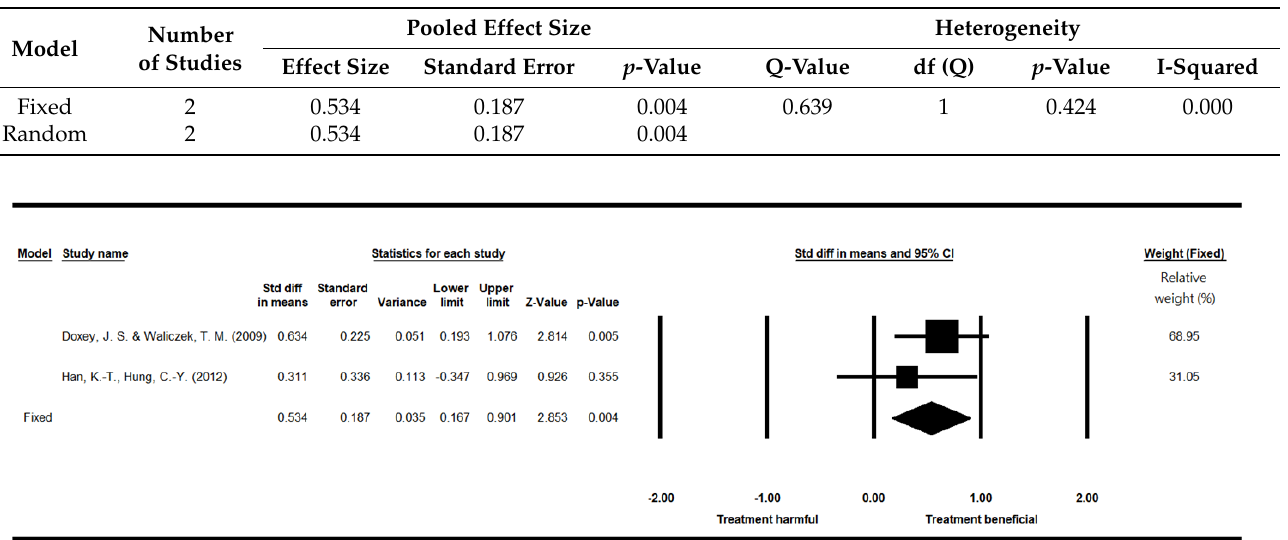
Table 18. Original data of the studies examining the influence of indoor plants on response time.